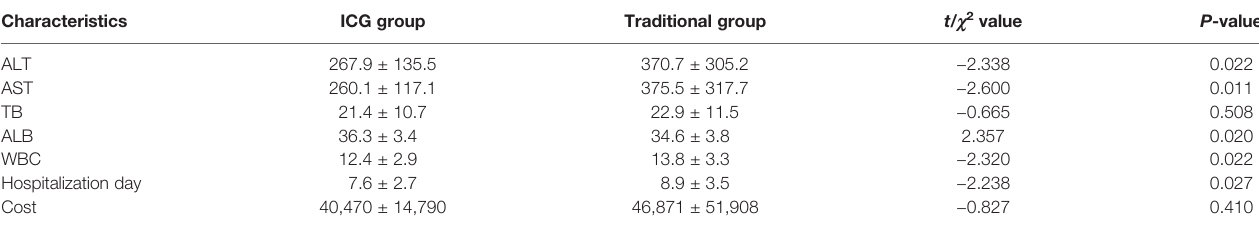
TABLE 4 | Postoperative index between the ICG-guided and traditional groups. Characteristics